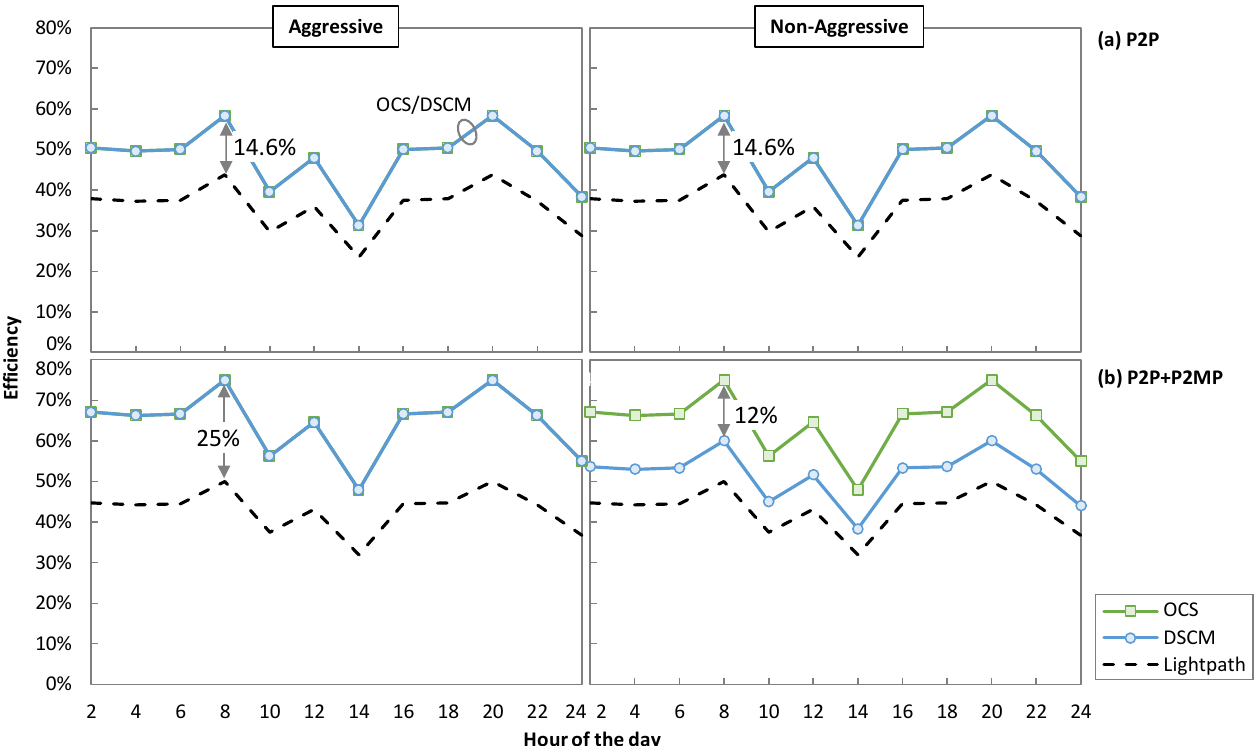
Figure 13. Efficiency of aggressive and non-aggressive availabilities for P2P ( a ) and P2P + P2MP ( b ) traffics.